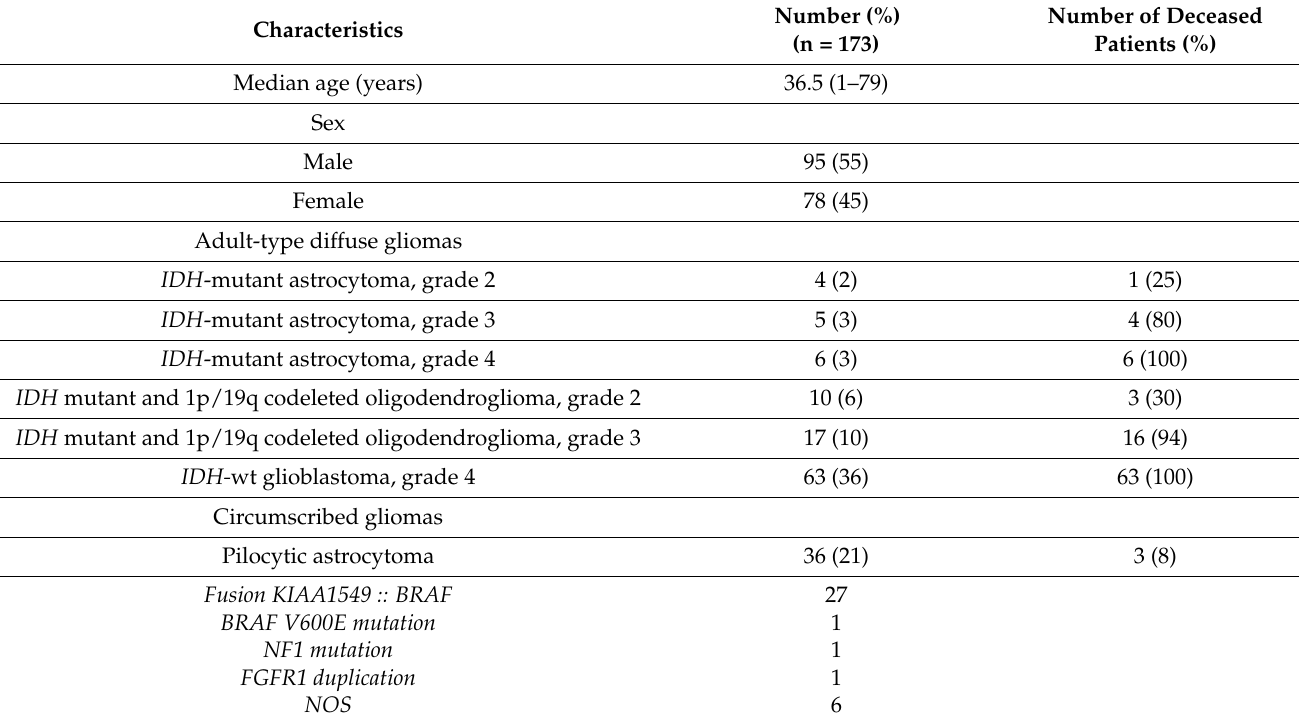
Table 1. Clinical characteristics of the